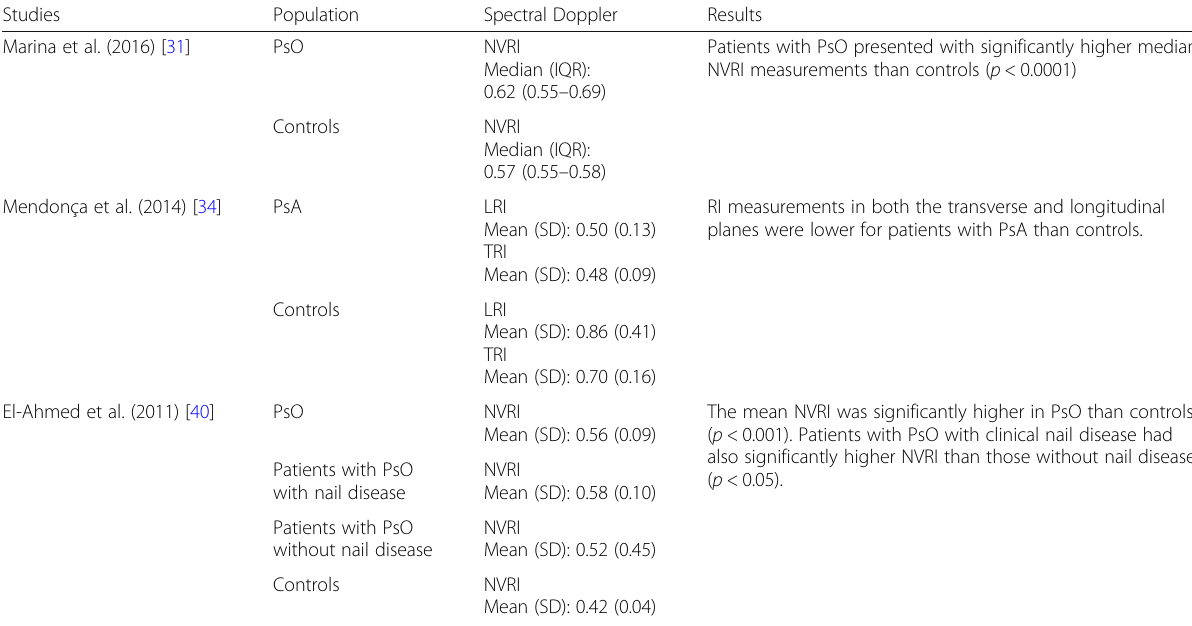
Table 5 Studies comprising quantitative results on spectral Doppler a Studies